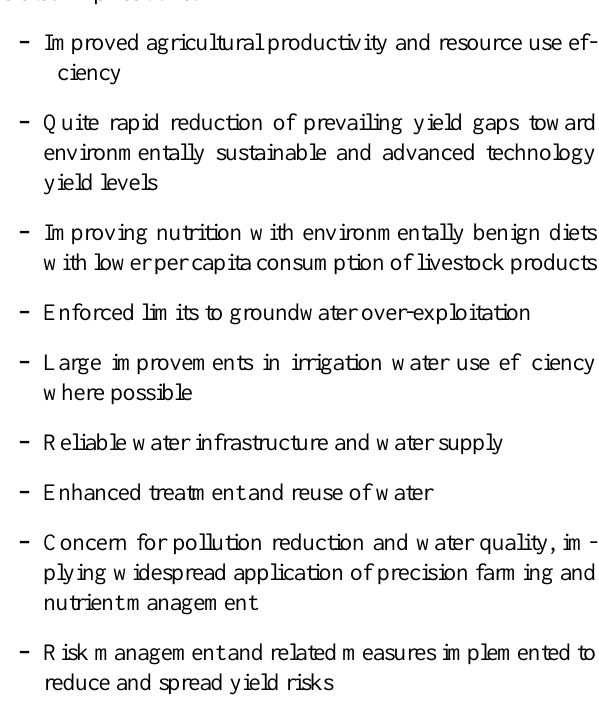
Table A1. Number of countries, area and population belonging to the four hydro-economic (HE) quadrants. Number Area Population of countries in million km 2 in million people HE-1 94 75.7 3443 HE-2 31